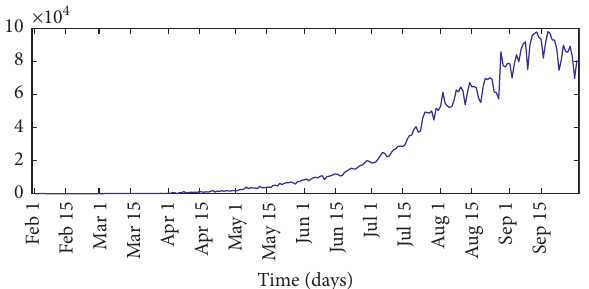
Figure 1: Daily reported COVID-19 cases from 31 st January 2020 to 29 th September 2020, India (source: